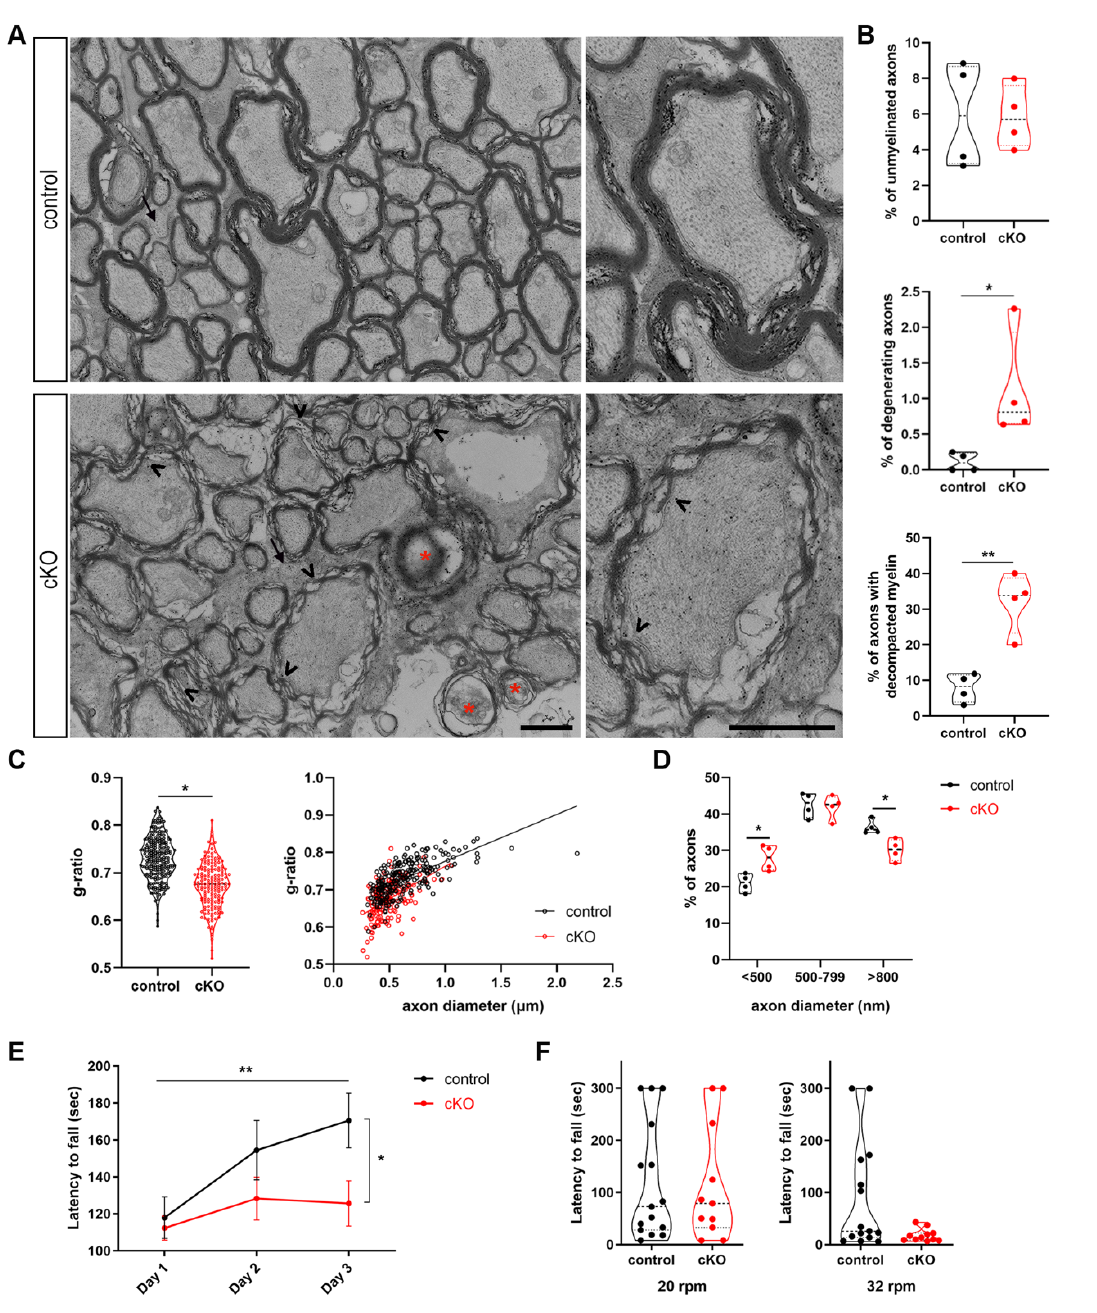
FIGURE 5: Autophagy in OLs is an essential mechanism for the maintenance of CNS myelin. (A) Ultrastructural analysis of optic nerves from plpCre ERT2 -; atg5 f/f (control) and plpCre ERT2 +; atg5 f/f (cKO) mice. Representative electron micrographs of cross sections of control and cKO optic nerves, demonstrating the presence of degenerating axons (indicated by red stars), decompacted myelin sheaths (arrowheads) and unmyelinated axons (arrows). (B) Quantification of axonal degeneration, decompacted myelin sheaths and unmyelinated axons in control and cKO mice. Violin plots presenting individual values (450-500 axons measured for each mouse, student’s t-test. N= 4 animals per genotype). (C) Myelin sheath thickness was assessed using g-ratio measurement of EM images from control and cKO animals. Plot of g-ratio values per ani- mal group (each point represents an axon) and g-ratio distribution to different axonal diameters of the two groups (linear regression, 260 measured for the control, 170 axons for the cKO group and n= 4 animals per genotype). Scale bar: 1 μm. (D) Quantitation of the percentage of axons with small (<500nm), medium (500-799nm) and large (>800nm) caliber in control and cKO optic nerves. (250 axons measured for each mouse, student’s t-test. N= 4 animals per genotype. *p < 0.05, **p ≤ 0.01. (E) Performance of mice in the rotarod task. Line graph showing latency to fall during training (3 days). N= 15 for control; n=11 for cKO. Two-way ANOVA (Tukey's multiple comparisons test) was used to determine statistical significance. For controls: Day 1 vs. Day 2, p=0.954; Day 2 vs. Day 3, p=0.6255; Day 1 vs. Day 3, p= 0.0093. For cKOs: Day 1 vs. Day 2, p=0.7105; Day 2 vs. Day 3, p=0.9907; Day 1 vs. Day 3, p= 0.7875. For day 3 (control vs cKO), p=0.0362. *p < 0.05, **p ≤ 0.01. (F) Violin plots showing latency to fall during the testing phase in the rotarod task. Control, n= 15; cKO, n=11. Student’s t-test was used to deter- mine statistical significance. At Day 4(20 rpm), p>0.9999; at Day 5(32 rpm), p= 0.1052. Data information: Bar graphs depict mean ±